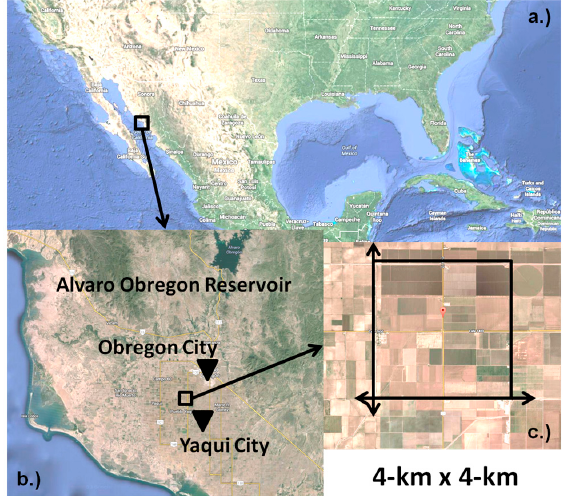
Figure 1. Study zone location in North America ( a ); the Sonora state ( b ); and the irrigated perimeter ( c ).